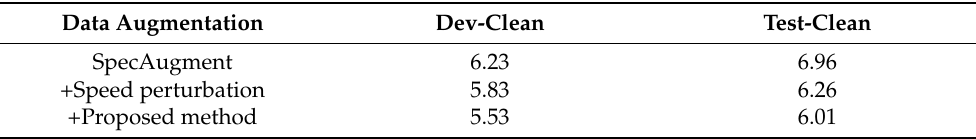
Table 8. WER (%) results of LibriSpeech database when incrementally combined with the previous data augmentation